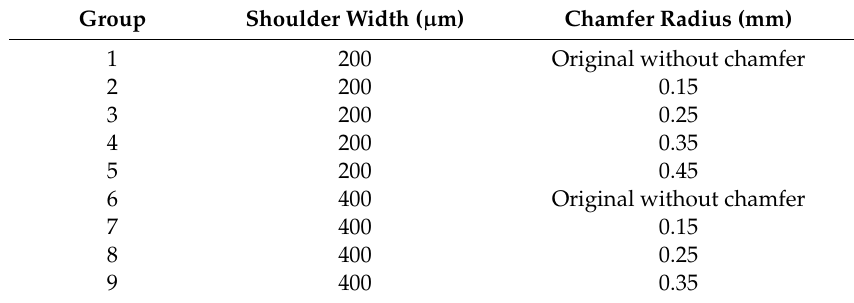
Table 3. Full-factorial simulation.